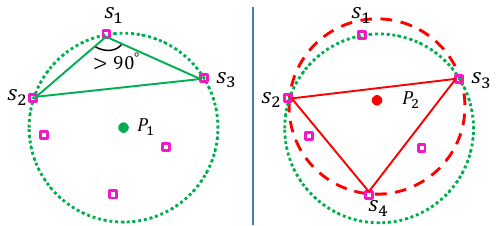
Figure 3. The green dotted circle having three targets on the circle is not the smallest since the triangle ∆ s 1 s 2 s 3 is an obtuse one; while the red dash circle is the smallest circle.